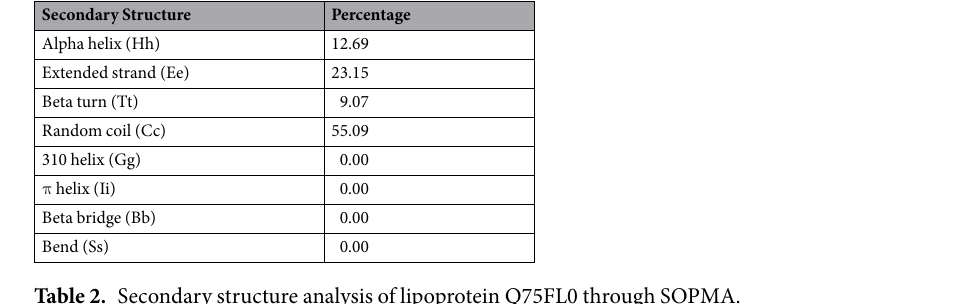
Table 2. Secondary structure analysis of lipoprotein Q75FL0 through SOPMA.